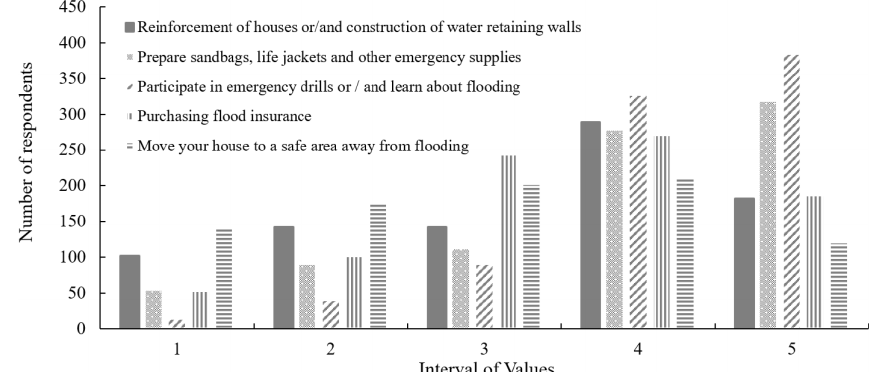
Figure 3. Results of frequency analysis of five adaptive measures. Numbers on the x axis denote the following: 1, strongly unwilling; 2, unwilling; 3, undecided; 4, willing; and 5, strongly